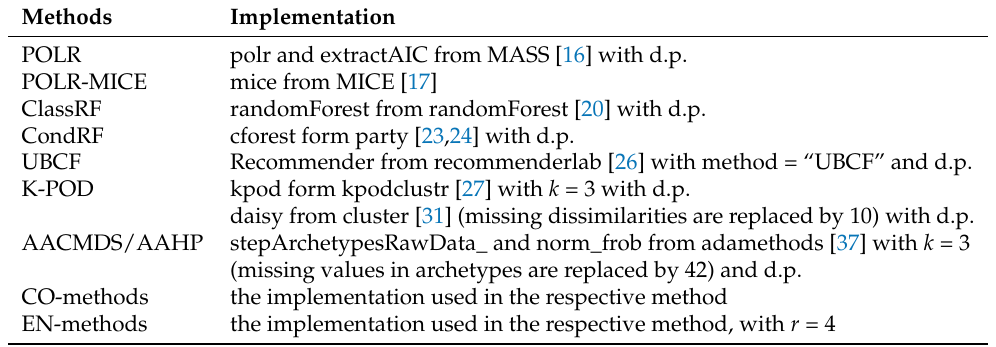
Table 2. Summary of the implementation of each method. Default parameters are denoted by d.p.